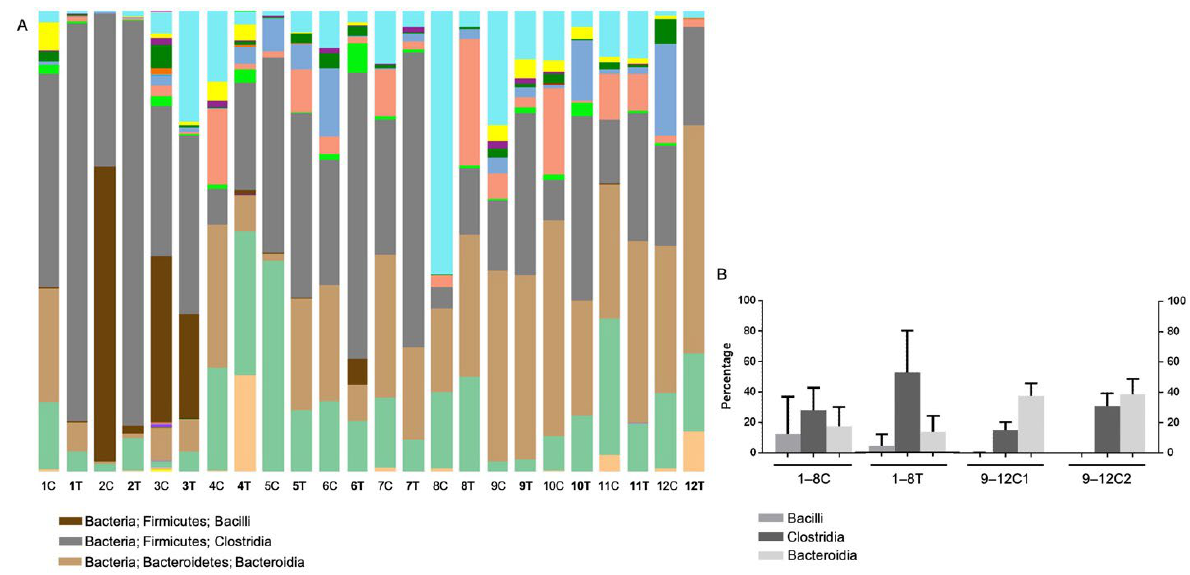
Figure 4. ( A ) Relative distribution of the bacterial classes in fecal microbiome of eight cats (1–8) from the treatment group and four cats (9–12) from the control group before and after the Bacillus licheniformis -fermented products (BLFP) treatment. The list of the represented bacterial classes of other color bars is provided in Figure S1. ( B ) Bar chart of the selected bacterial class components in cats having diarrhea before (1–8C) and after (1–8T) BLFP treatment and in non-diarrheal cats without having BLFP (9–12C1 and C2). C: before the BLFP treatment; T: after the BLFP treatment; C1: first sampling of feces in the control group; C2: second sampling of feces in the control group.